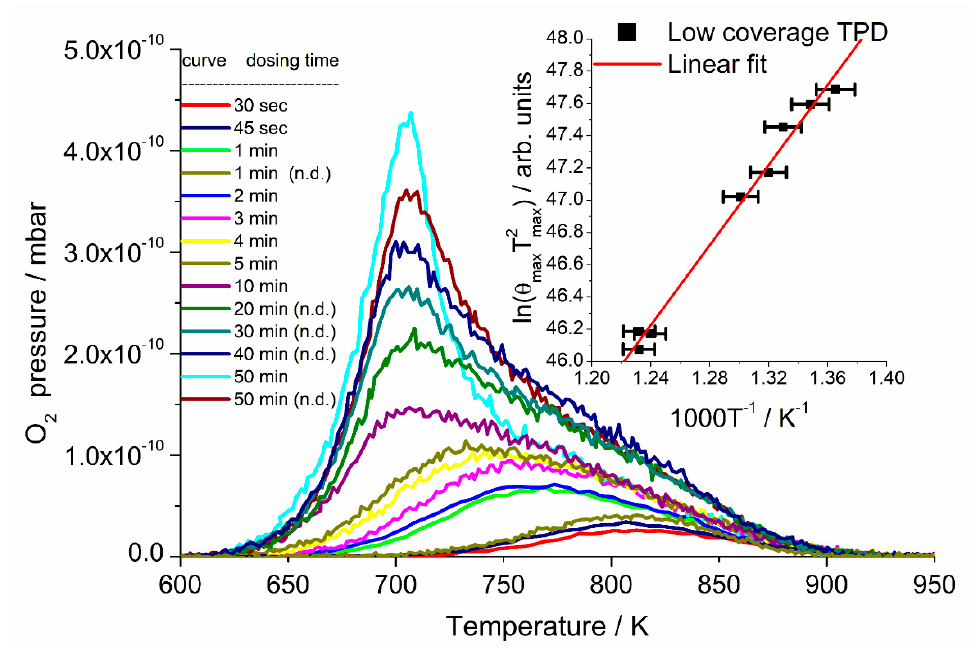
Figure 5. TPD-spectra of oxygen on Pt{110} for different exposures. The sample was dosed at 420 K with a pressure of 1 × 10 − 8 mbar O 2 . The measurements were performed on two different days (indicated by n.d. for next day’s results). Due to the extreme sensitivity of oxygen TPD to the surface structure, the TPD spectra of each day differ slightly from each other. The heating rate was 4 K/s. The insert shows a plot of the TPD peak maximum at low coverage according to equation (3) for exposures up to 5